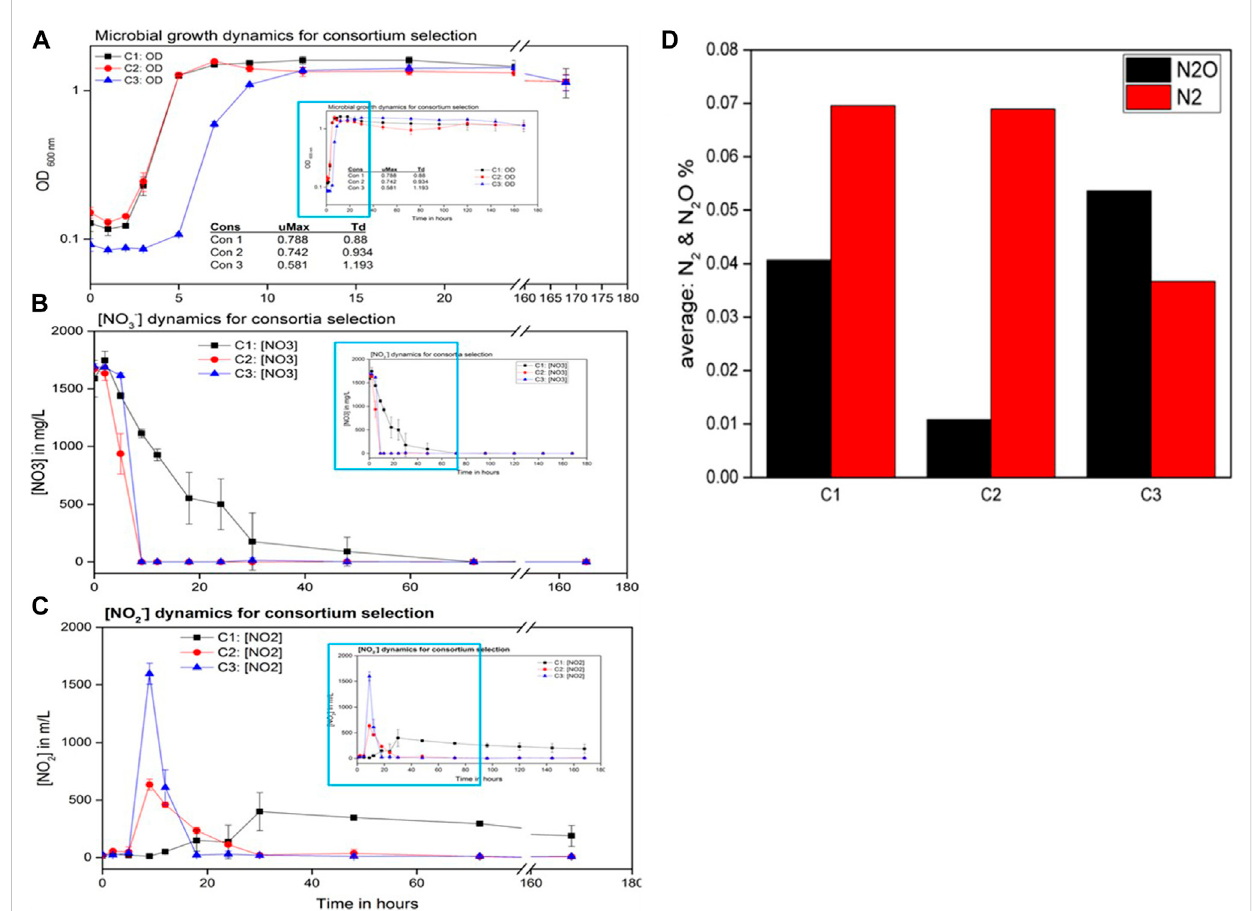
FIGURE 3 Complete denitri fi cation dynamics for consortium selection studies. (A) Microbial growth curves, (B) NO 3 − reduction dynamics, (C) NO 2 − reduction dynamics, and (D) copper effect on the reduction of nitrous oxide (N 2 O) and production of nitrogen (N 2 ) percentages in the three consortia (C1, C2, and